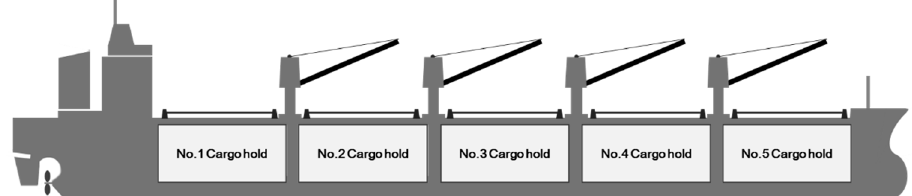
Figure 1. Typical layout of a bulk carrier with deck cranes [22].